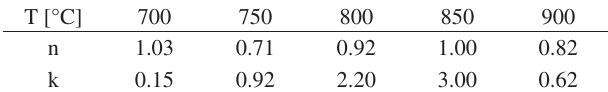
Table 2. n-exponent and k factor of JMA equation for sigma phase formation from ferrite in the studied DSS.